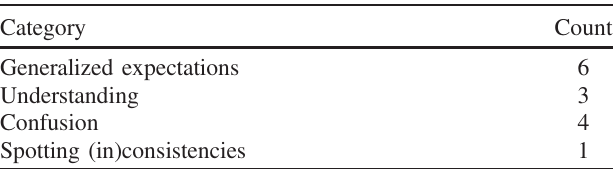
TABLE III. Bill ’ s BESM talk in a 6 min episode.